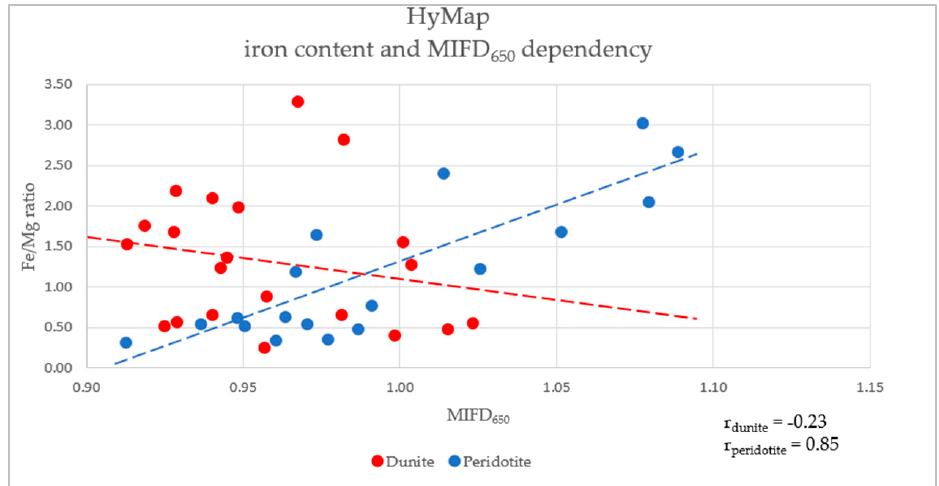
Figure 10. In-situ Fe/Mg ratio of the validation points versus MIFD 650 for HyMap data. Dashed lines show the fitted linear trendline for each lithology with the corresponding color. r values represent the correlation coefficient for each lithology. The dunite body in the eastern part of the ultramafic complex shows a high abundance of large MIFD 1000 values (dark red color), whereby MIFD 650 values are lower abundant (light green color) in this area compared to its surroundings (Figure